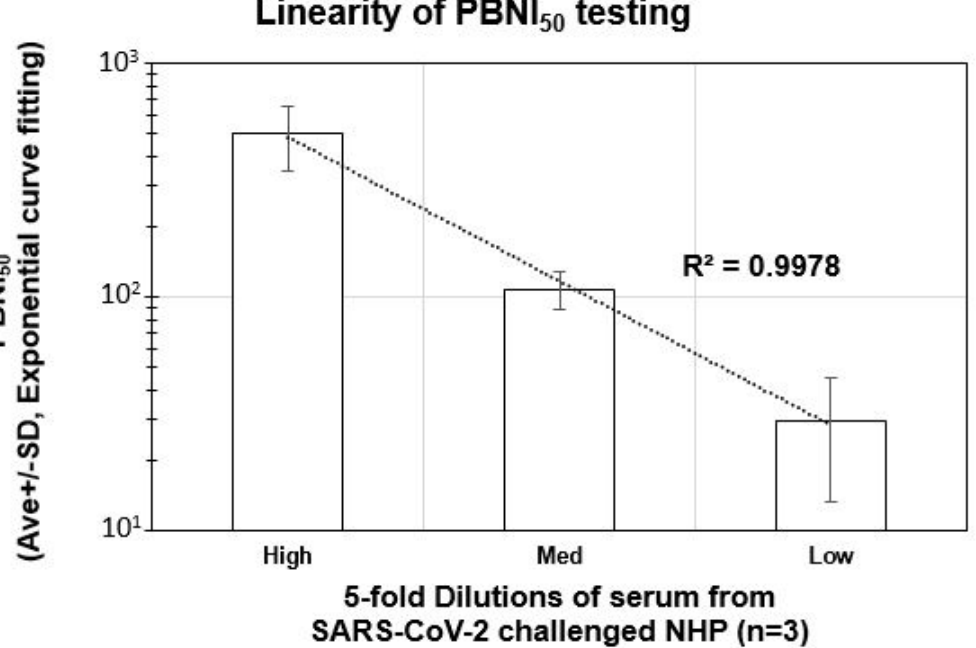
Figure 4. Linearity of PBNI 50 testing: three (3) serum samples from SARS-CoV-2-challenged NHPs (1M16756, 3M16763, 3F16765) with a high PBNI 50 were serially diluted 5-fold to generate test samples with a high, medium, and low PBNI 50 , followed by a PBNA with 6-point dilution in triplicate at each dilution. The average ± SD of the three PBNI 50 for high, medium and low test samples are shown on the Y -axis. The X -axis denotes the test samples with high, medium, and low PBNI 50 . Trend analysis between the three groups is shown by the dotted line (R 2 = 0.9978).